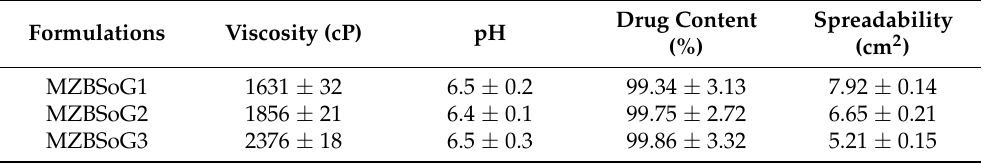
Table 4. Characterization of different optimized miconazole bilosome